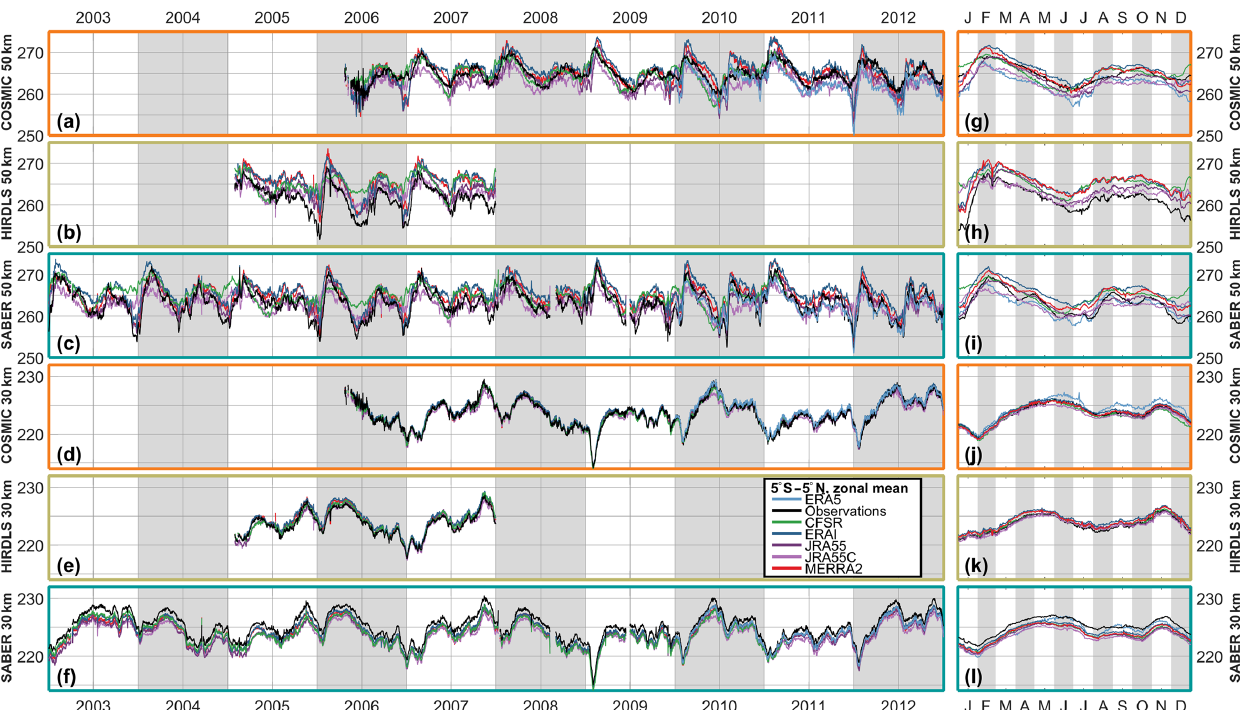
Figure 7. Time series of observed and sampled-reanalysis temperature, averaged over 5 ◦ S–5 ◦ N, at (a–c, g–i) 50km and (d–f, j–l) 30km in altitude. Panels (a) – (f) show time series over the period 2003–2012, and panels (g) – (l) the annual cycle derived from the extended time